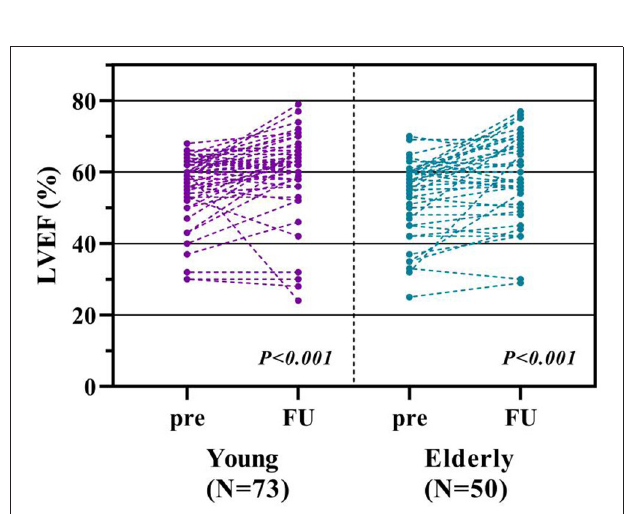
FIGURE 5 | Comparison of echocardiographic measurements. Figure from the left to the right showed the comparison of preprocedural and the 12th month measurements of left ventricular ejection fraction (LVEF) between young and elderly